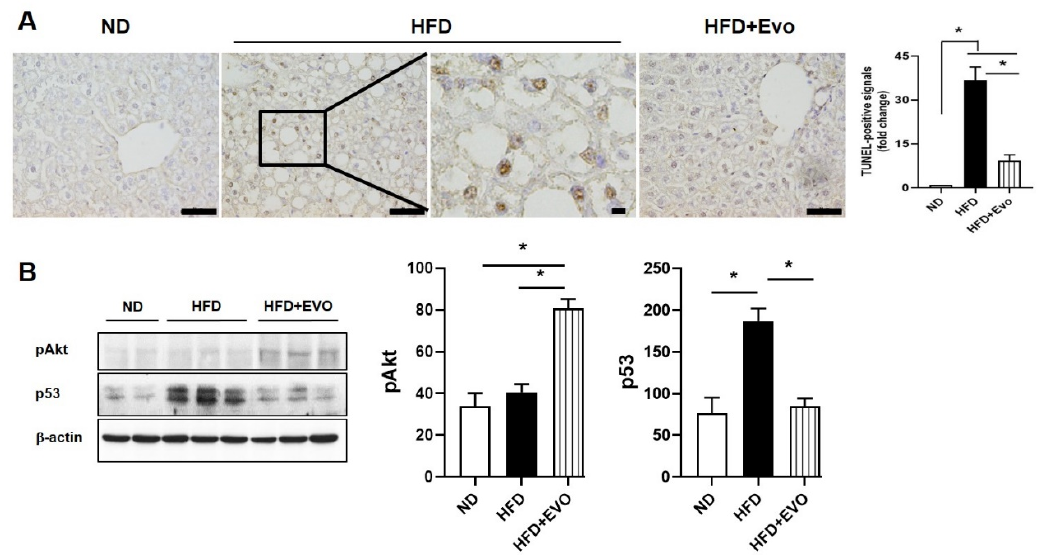
Figure 6. Effect of evogliptin on hepatic cell death by HFD: ( A ) Representative images of TUNEL-stained liver sections from each group. HFD-induced positive signals (black box) were magnified. Scale bar, 50 μm. ( B ) Proteins expressions related to apoptosis and the quantitative results. Values are mean ± SEM. * p < 0.05, TUNEL: terminal deoxynucleotidyl transferase dUTP nick end labeling; HFD: high-fat diet; ND: normal diet.